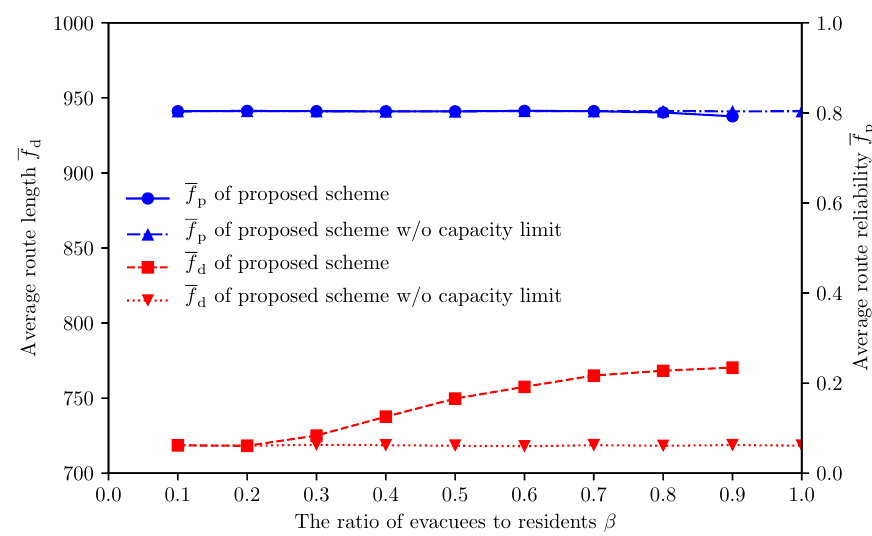
Figure 11. Impact of β on f